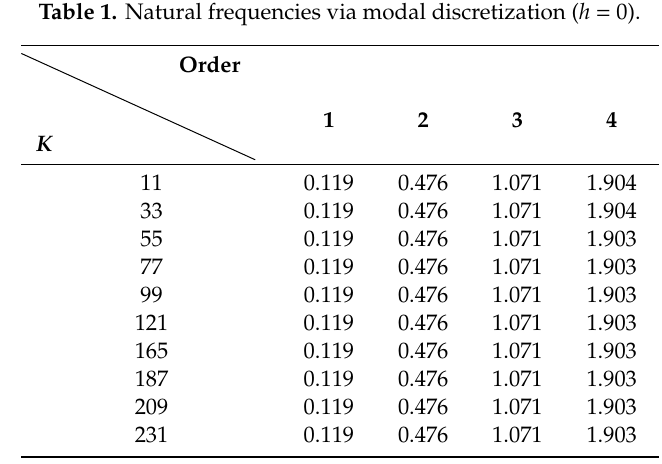
Table 1. Natural frequencies via modal discretization ( h = 0).